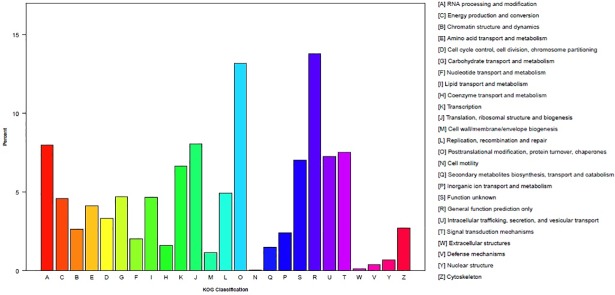
KOG functional classification of the sea buckthorn transcriptome.Note: 16,019 unigenes with significant homologies in the KOG database (E-value <10−5) were classified into 26 KOG categories. Capital letters on the x-axis indicate KOG categories on the right side of the histogram; the y-axis indicates the percentage of unigenes.